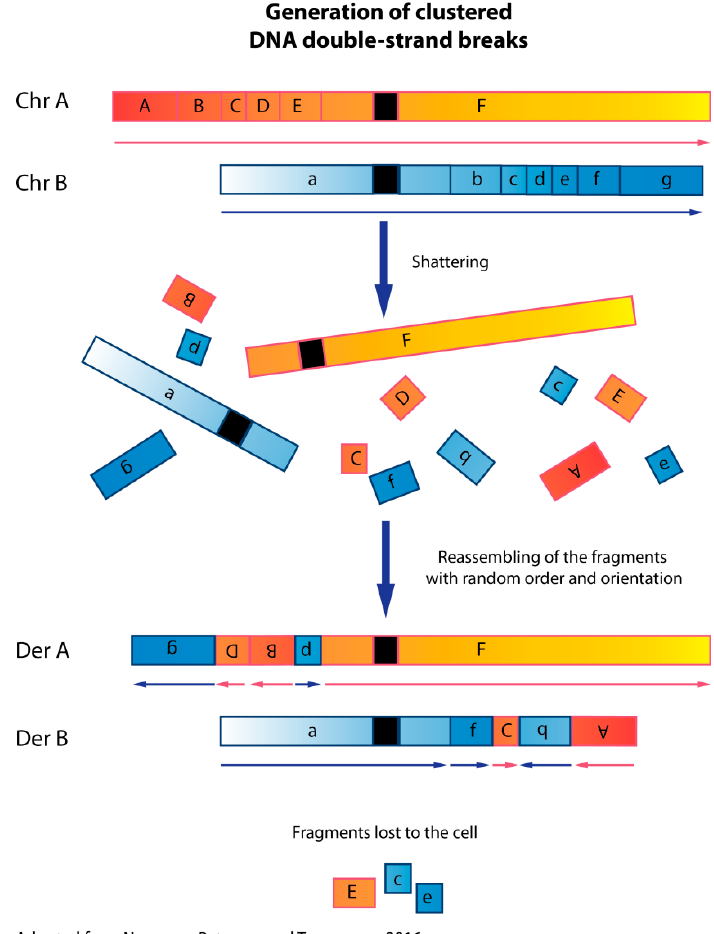
Figure 1. Schematic mechanism of chromothripsis. The first step of chromothripsis is the generation of clustered DNA double-strand breaks. Chromothripsis may involve one or a few chromosomes, a chromosomal arm (both p and q arms), or an entire chromosome. This results in multiple fragments that are stitched together in a random order and orientation by DNA repair machineries. During this process, some of the fragments may be lost. The derivative chromosome(s) will contain complex structural rearrangements. By piecing together all the structural variants detected by paired-end or mate-pair sequencing, it should be possible to delineate the derivative chromosomes.